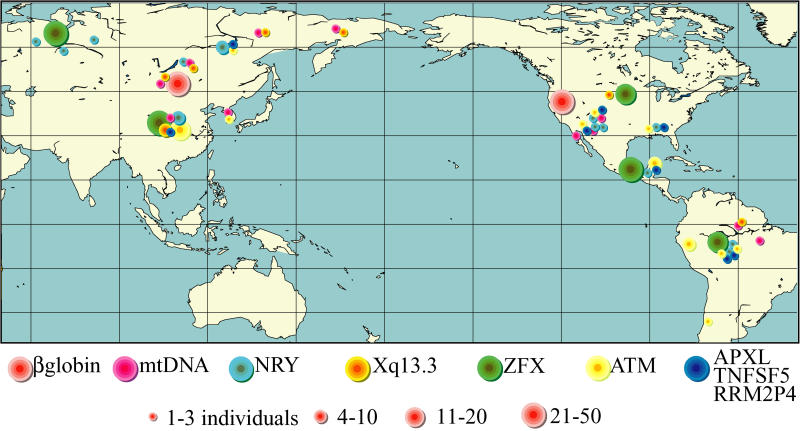
Approximate Geographic Locations, and Sample Sizes per location, for Each Locus Listed in Table 1
In some cases locations are based on actual geographic locations, in other cases the locations are the approximate center of the geographic region occupied by ethnic groups identified in the original references (Table 1).